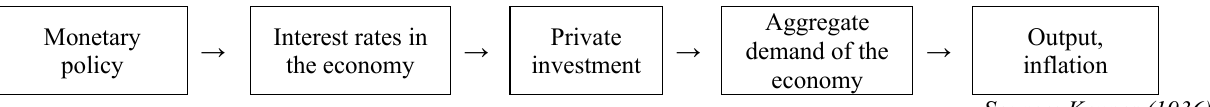
Fig. 1. The monetary transmission mechanism to economic of